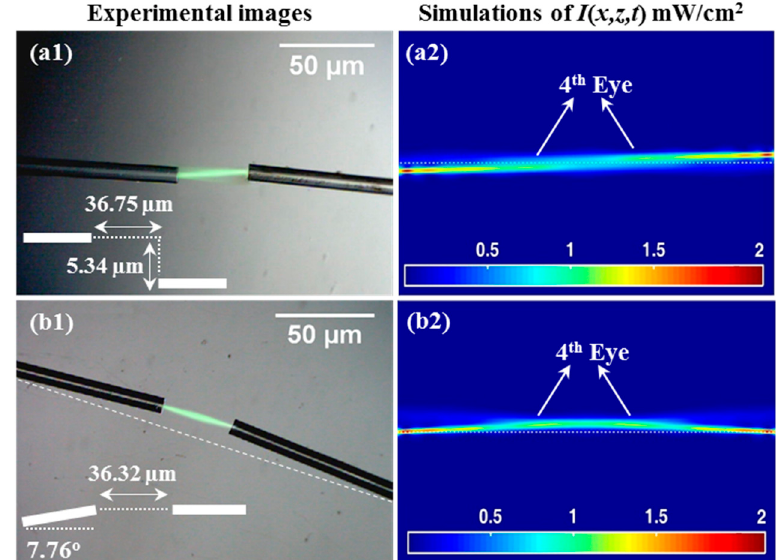
Figure 7. SWW for coupling single mode optical fibers at t exp = 1600 s of λ = 532 nm and P 0 = 0.1 mW (i.e., each fiber has P 0 = 0.1 mW). Experiments and simulations: ( a1,a2 ) separated by 36.75 µ m with shafting of 5.34 µ m and ( b1,b2 ) separated by 36.32 µ m with an angle of 7.76 ◦